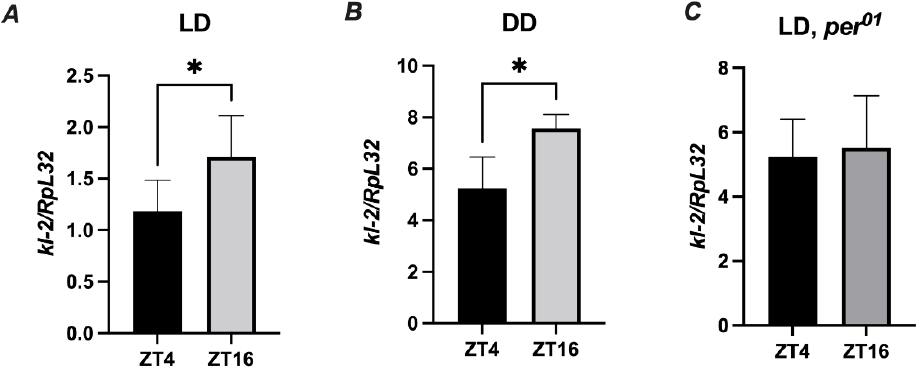
Figure 6. kl-2 expression in D. melanogaster is rhythmic. Canton S ( A , B ) and per 01 flies were maintained in light/dark LD 12:12 ( A , C ) or constant darkness conditions ( B ). Flies were collected at ZT4 (four hours from the beginning of the day) or ZT16 (four hours from the beginning of the night) and total RNA from the abdomen was subjected to RT-qPCR. Relative expression of kl-2 is shown as mean ± SD (N = 5 independent experiments, with 25 flies in each). Statistically significant differences between groups are indicated as * p < 0.05 by two-tailed Student’s t-test.